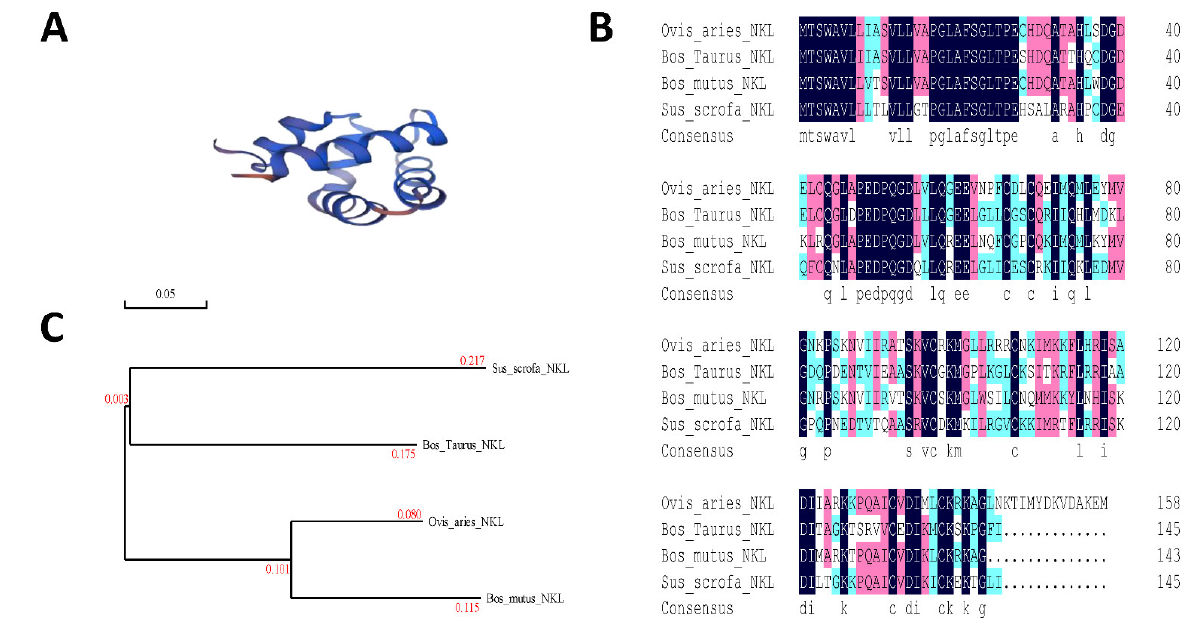
Figure 1. Phylogenetic analysis of Porcine NK-Lysin. ( A ), prediction model of PNKL; ( B ), phylogenetic analysis of PNKL in Sus scrofa , Ovis aries , Bos Taurus , and Bos mutus were performed by DNAMAN 8.0; ( C ), amino acid sequences of PNKL in Sus scrofa , Ovis aries , Bos Taurus , and Bos mutus were aligned by DNAMAN 8.0.